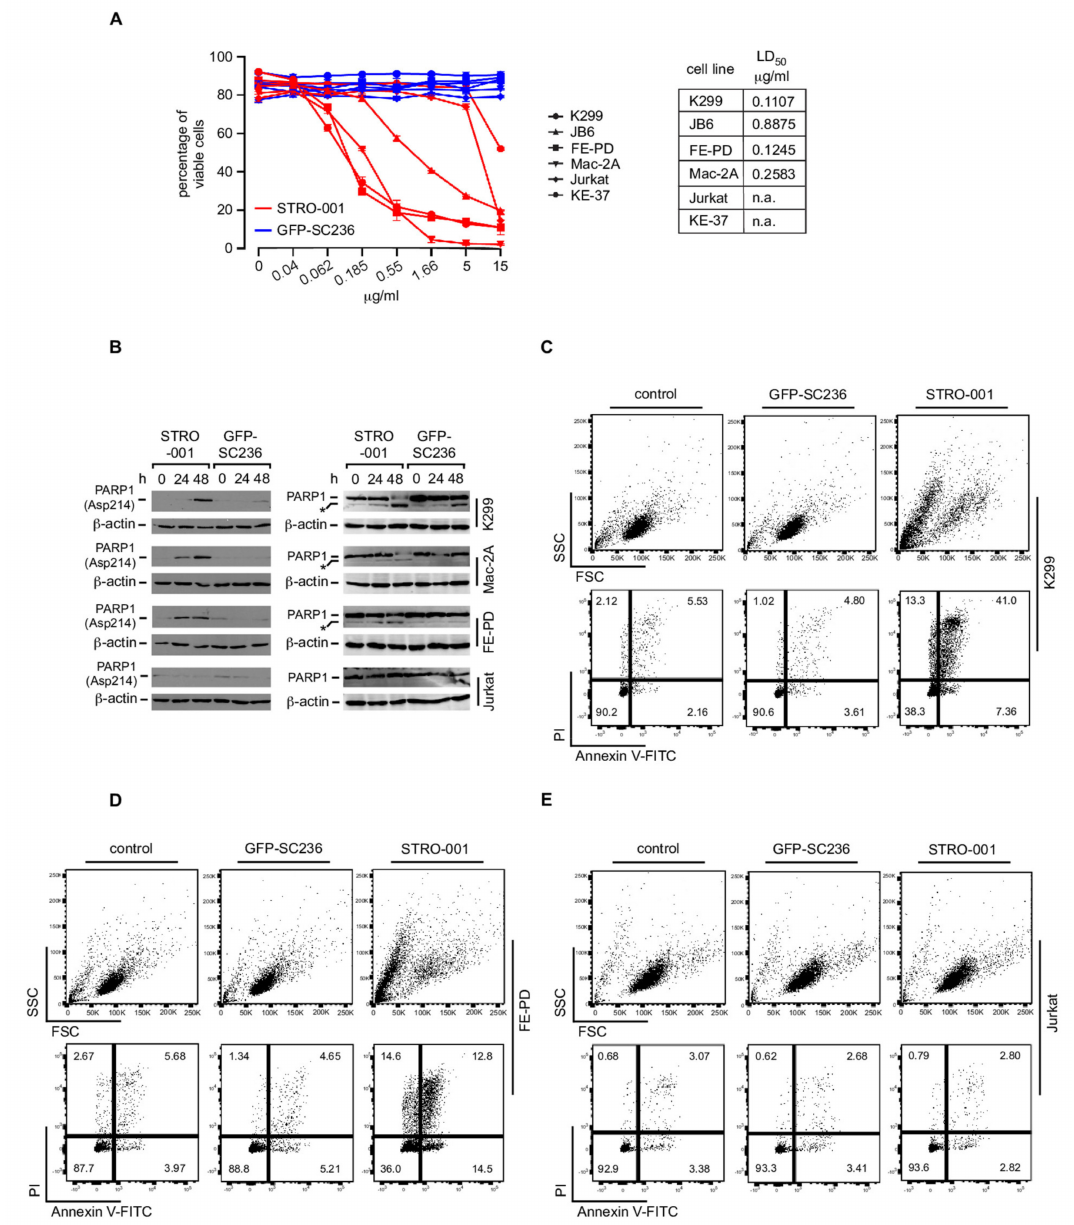
Figure 5. Induction of apoptotic cell death by the CD74-targeting antibody-drug conjugate (ADC) STR-001. ( A ) Left, the indicated ALCL cell lines (K299, JB6, FE-PD, Mac-2; all CD74 positive) as well as the T cell control cell lines Jurkat and KE-37 (both CD74 negative) were treated with various concentrations of the CD74-targeting ADC STRO-001 (red lines) or, as